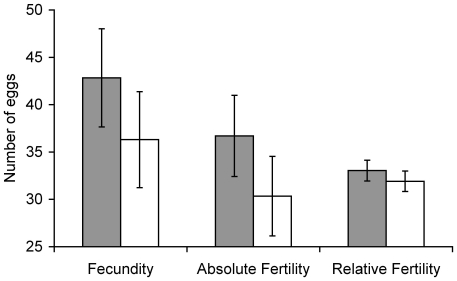
Fecundity, absolute fertility and relative fertility, summed over the 10-day observation period, for females that received either a single additional mating (shaded bars) or an interrupted mating (open bars).Data displayed as least squares means ± SE.